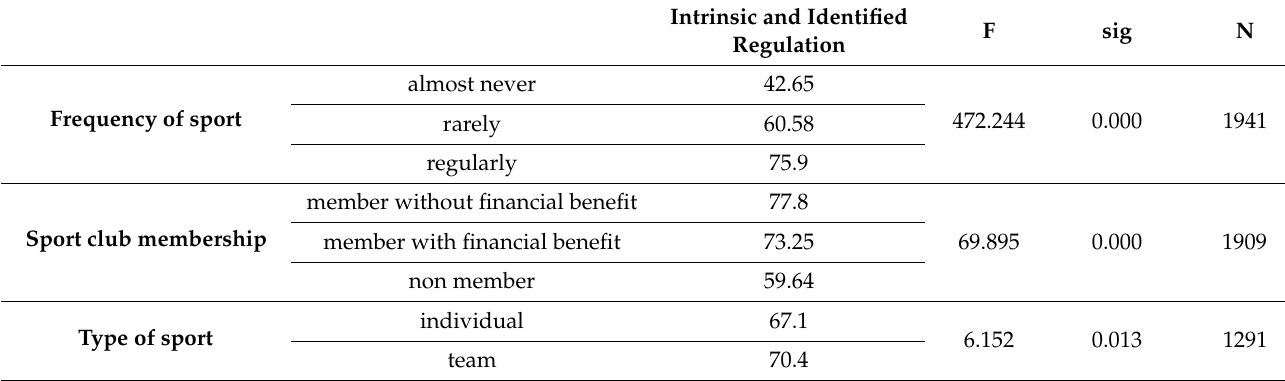
Table 1. Means of intrinsic and identified regulation according to sporting habits (on a scale of 0–100) Source: PERSIST